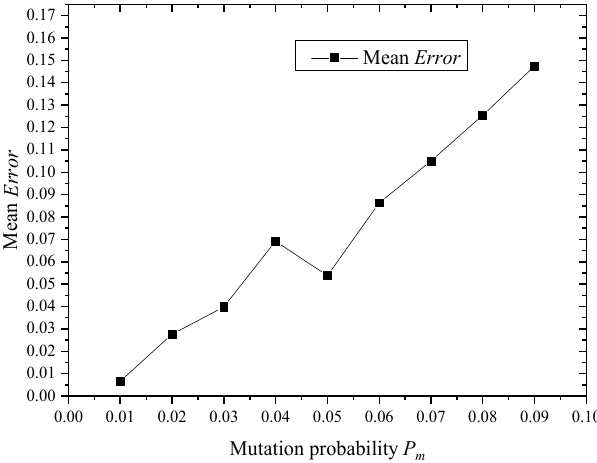
Figure 5. The mean Error values obtained by the DGA with different p m.